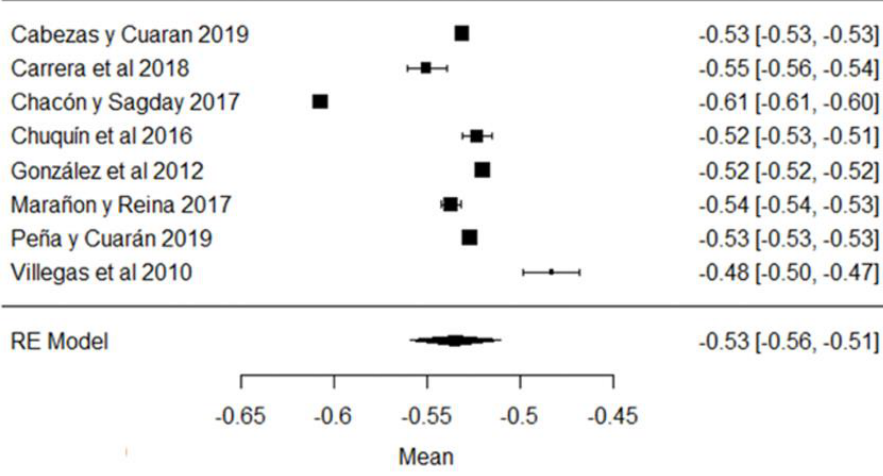
Figure 4. Cryoscopy forest plot [14,33,38,42,44,53,69,79] .